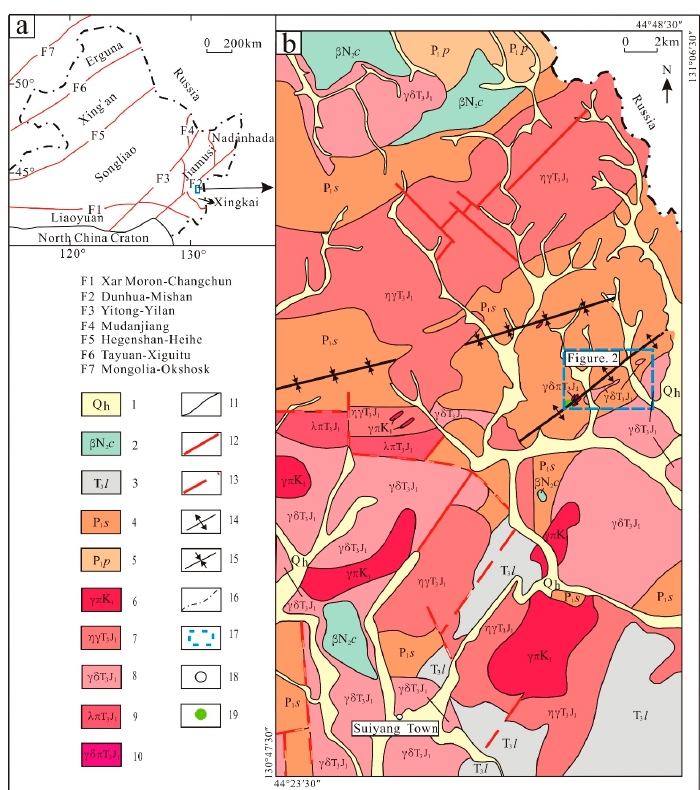
Figure 1. ( a ) The structural location map of the Yanghuidongzi mining area [23] and ( b ) regional geological map of the Yanghuidongzi area [24,25]: 1—Holocene; 2—the Neogene Chuandishan basalt Formation; 3—the Triassic Luoquanzhan Formation; 4—the lower Permian Shuangqiaozi Formation; 5—the lower Permian Pingyangzhen Formation; 6—Early Cretaceous granite porphyry; 7—Late Triassic-Early Jurassic monzonitic granite; 8—Late Triassic-Early Jurassic granodiorite; 9—Late Triassic–Early Jurassic rhyolite porphyry; 10—Late Triassic–Early Jurassic granodiorite porphyry; 11—Geological boundary; 12—measured fault; 13—inferred fault; 14—anticline; 15—syncline; 16—national border line; 17—Yanghuidongzi mining area; 18—residence point; 19—copper deposit. The strata in the area primarily comprise the lower Permian Pingyangzhen Formation (P 1 p ), the lower Permian Shuangqiaozi Formation (P 1 s ), the Triassic Luoquanzhan Formation (T 3 l ), the Neogene Chuandishan Formation ( β N 2 c ), and the Holocene (Qh) (Figure 1b). The magmatism in the area is intense, and intermediate-acid intrusive rocks of the Middle-Late Triassic, Early Jurassic, and Early Cretaceous are widely developed (Figure 1b). The Dunhua–Mishan deep fault (F2) of the Mesozoic is closely related to the magmatism, and the NW–NE trending faults have established the structure pattern of the study area (Figure 1b).